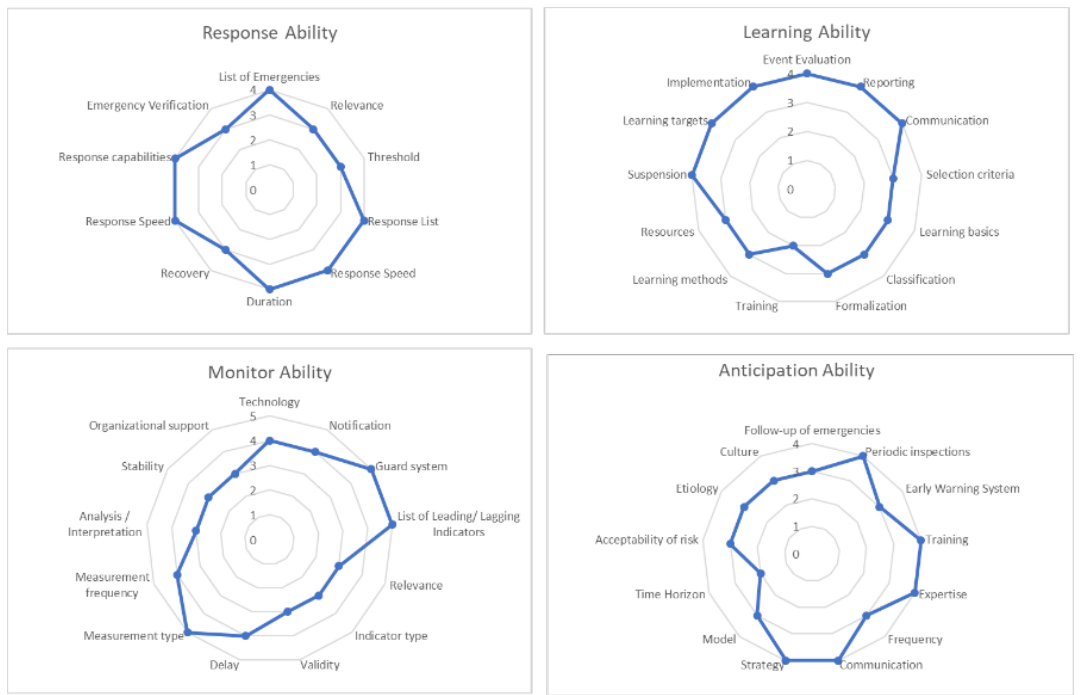
Figure 4. Ability analysis of safety resilience elements of the private company.